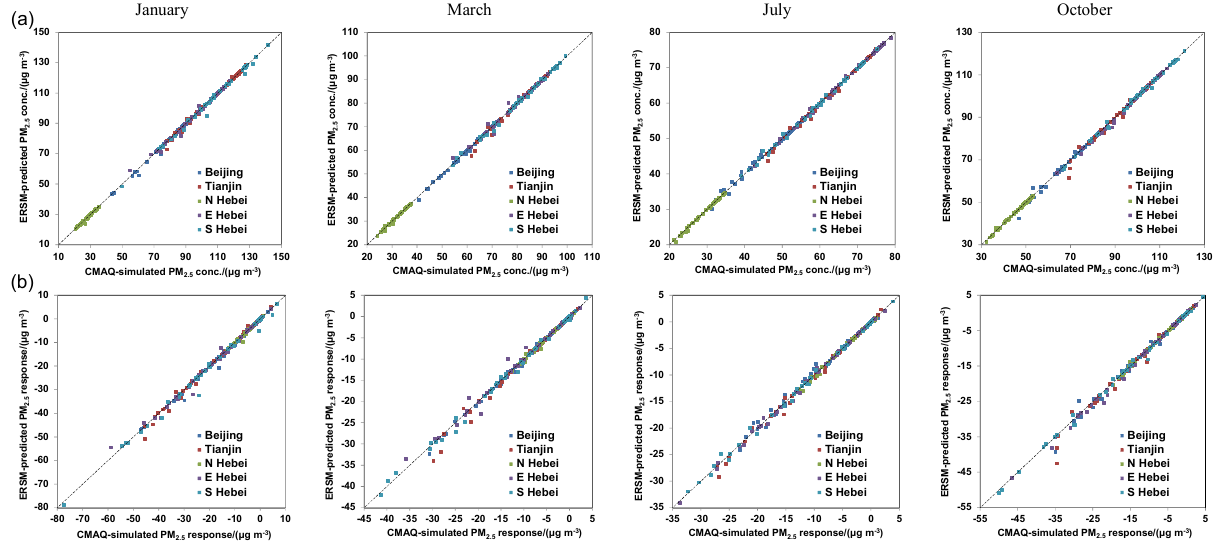
Figure 2. Comparison of PM 2.5 concentrations (top row) and PM 2.5 responses (bottom row) predicted by the ERSM technique with out-of-sample CMAQ/2D-VBS simulations. The dashed line is the one-to-one line indicating perfect agreement.